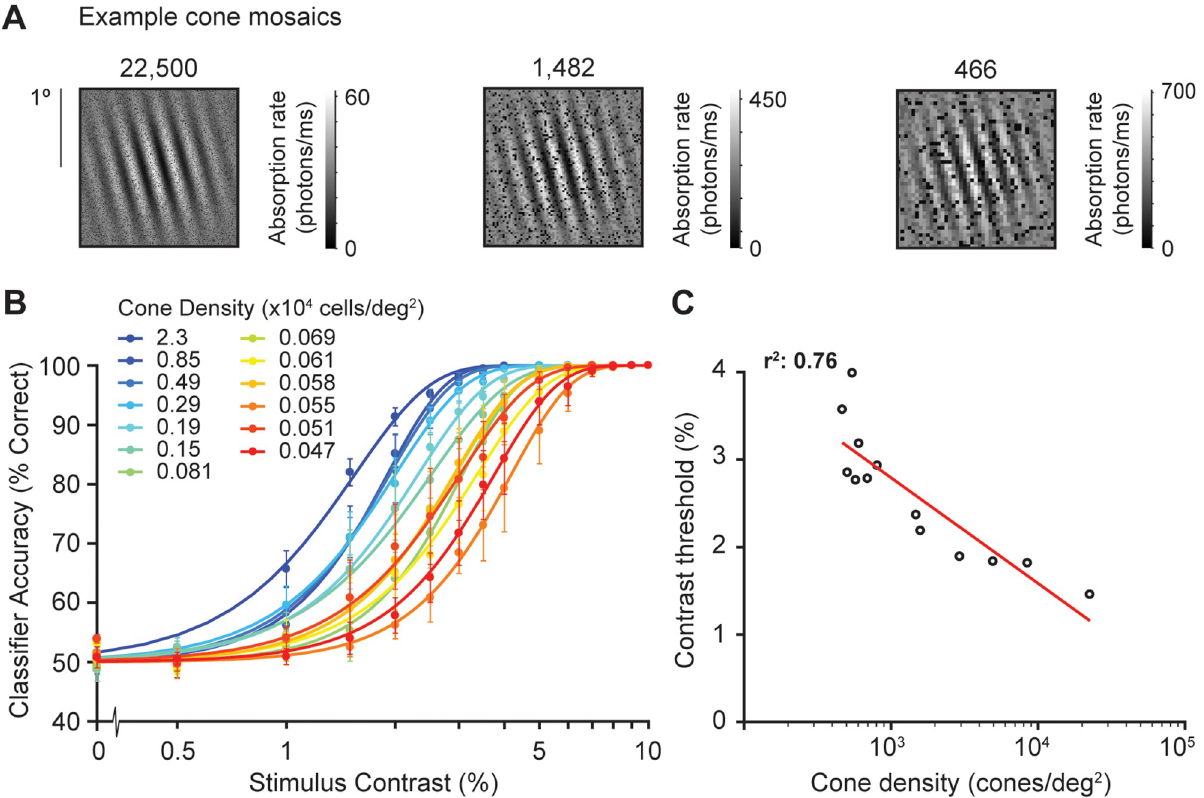
Fig 9. The effect of cone density on model performance. (A) Example cone mosaics simulated by our computational observer model. The highest tested cone density (22,500 cones/deg 2 ) is equivalent to the cone density in the fovea (0˚) whereas the lowest (466 cones/deg 2 ) is equivalent to a cone density at 40˚ eccentricity, according to data from Curcio et al. [40]. In our computational observer model, lower cone density implicitly results in larger absorption rates, because the cone area increases and therefore captures more photons. (B) Classifier accuracy for absorption rates as a function of stimulus contrast for 13 different cone density levels, each psychometric function is the average across performance of 2,000 trials per stimulus contrast (30,000 trials in total). Error bars represent standard error of the mean across 5 simulated experiments with 400 trials for each stimulus contrast. (C) Contrast thresholds from panel B as a function of log cone density (cones/deg 2 ), fitted with a log-linear